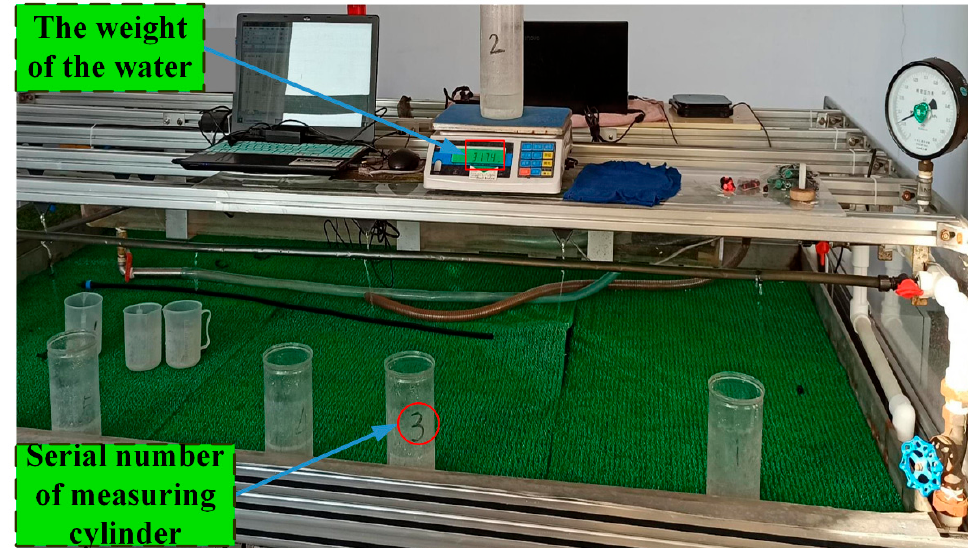
Figure 4. Drip irrigation emitters flow test platform.